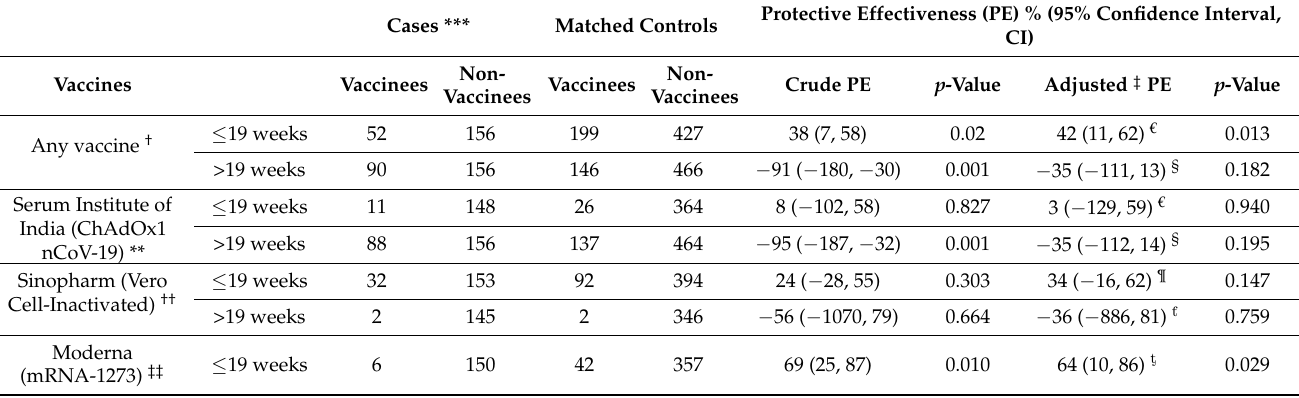
Table 4. Protection against any symptomatic COVID-19 disease by complete regimens of vaccine, shown according to time since the second dose